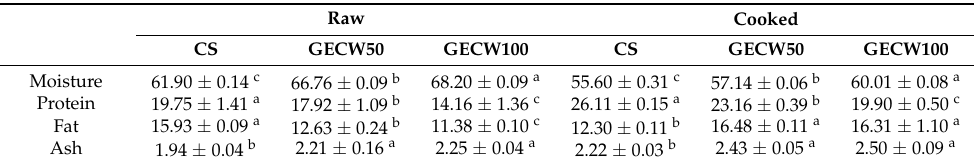
Table 2. Chemical composition of the raw and cooked beef burger elaborated with cocoa bean shell flour and walnut oil emulsion gel as partial and total pork backfat replacers. Raw Cooked CS